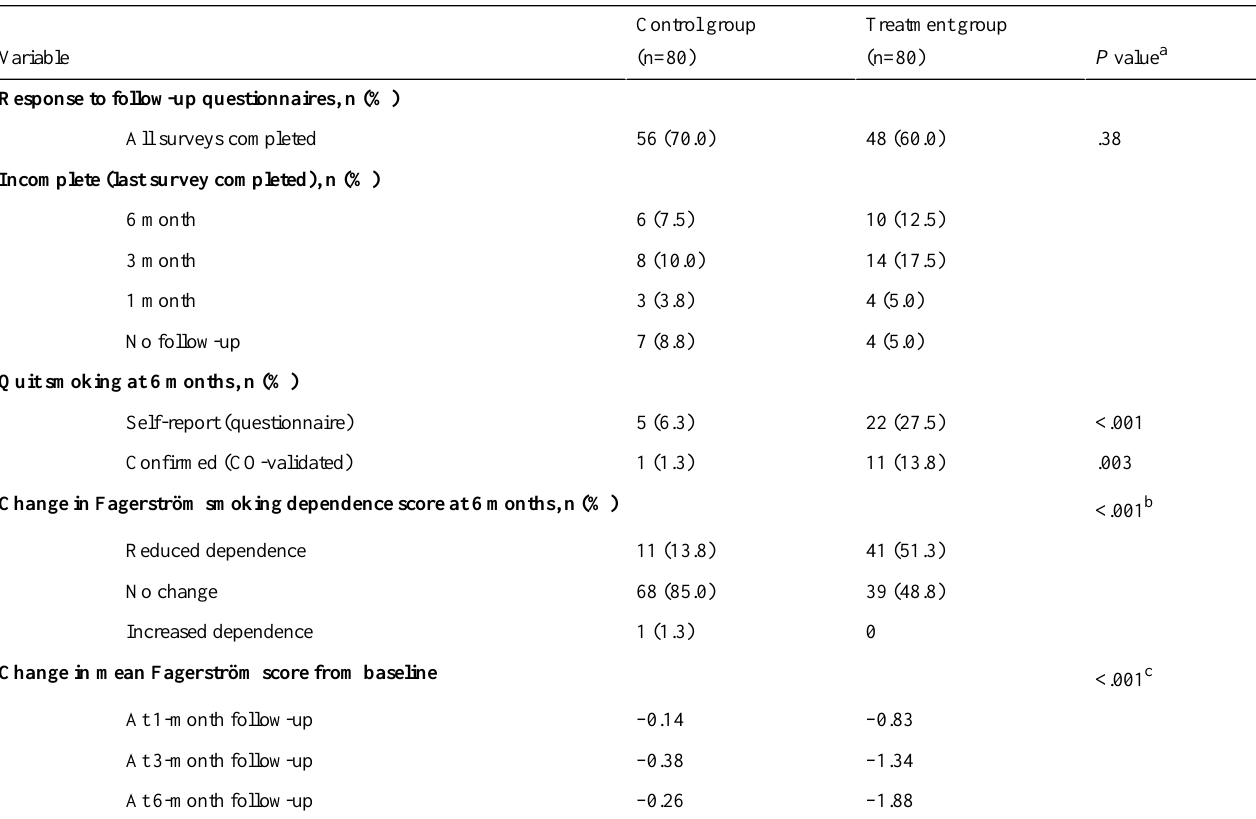
Table 3. Pattern of survey completion and change in smoking behavior at 6-month follow-up